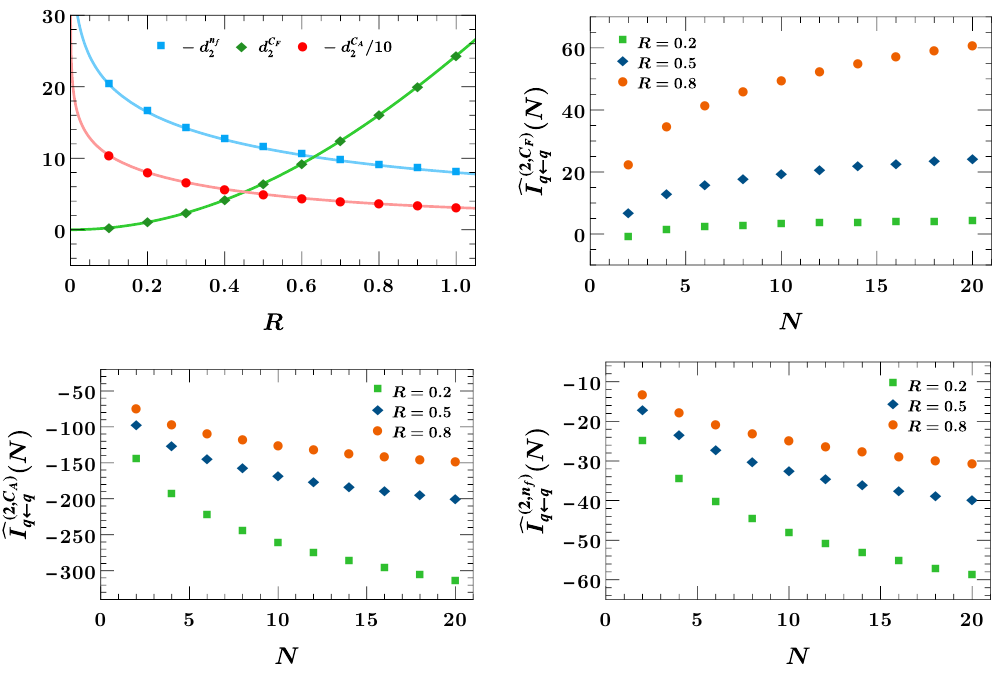
Figure 1 . Upper left: two-loop anomaly exponent d 2 as a function of the jet radius R . The dots show the results of our numerical evaluation, and the lines represent the expansion from [5]. Other: non-logarithmic terms of the NNLO matching kernels defined in (4.5) for three different values of the jet radius R .